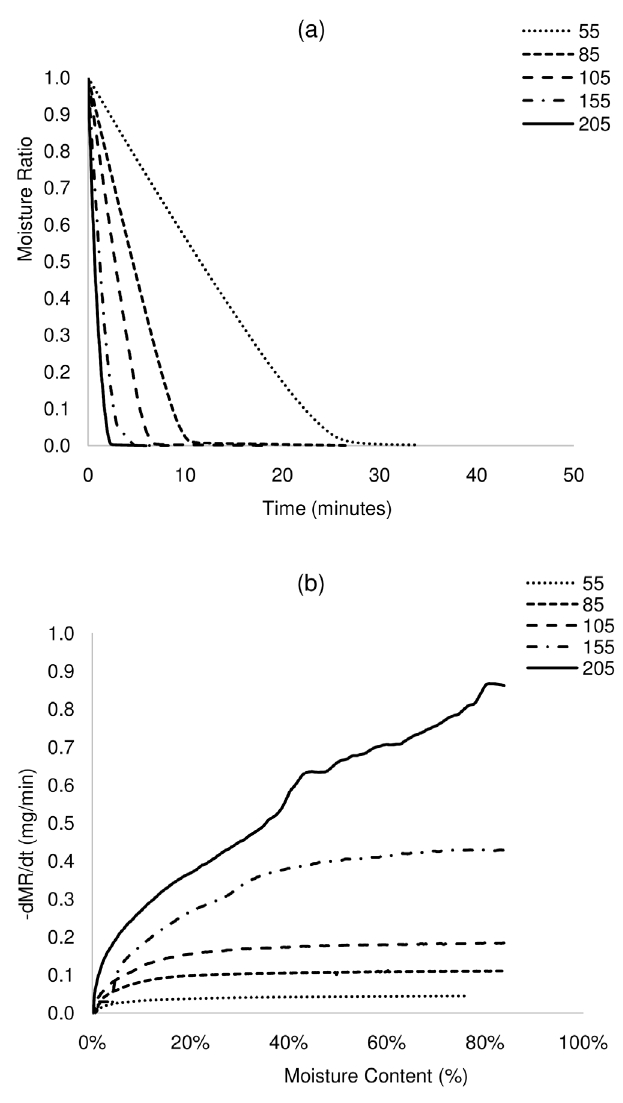
Figure 2. Isothermal drying curves of ABR at 55 – 205°C. a ) MR versus time and b ) drying rate versus moisture content. ABR, anaerobic baffled